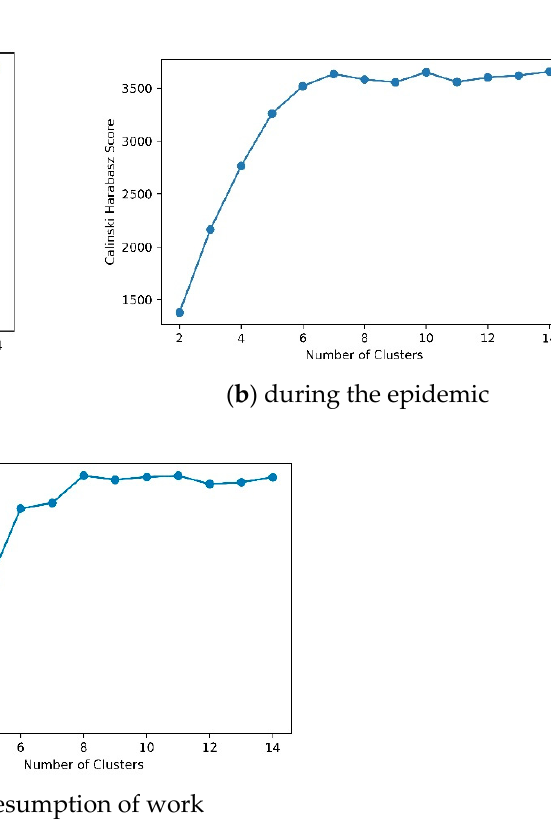
Figure 5. Relationship between the CH coefficient and K values at different stages of the epidemic.